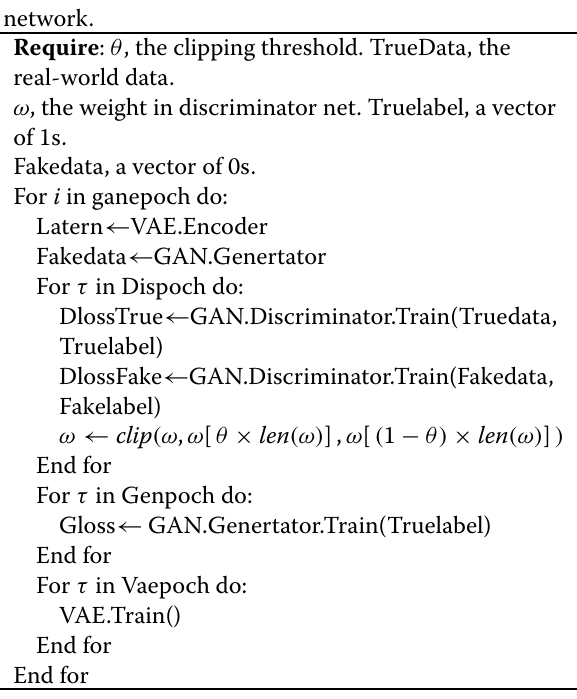
Algorithm 1: VAECGAN training process. The VAE model consists of the Encoder network and the Decoder(generator) network. The GAN model con- sists of the Generator network and the